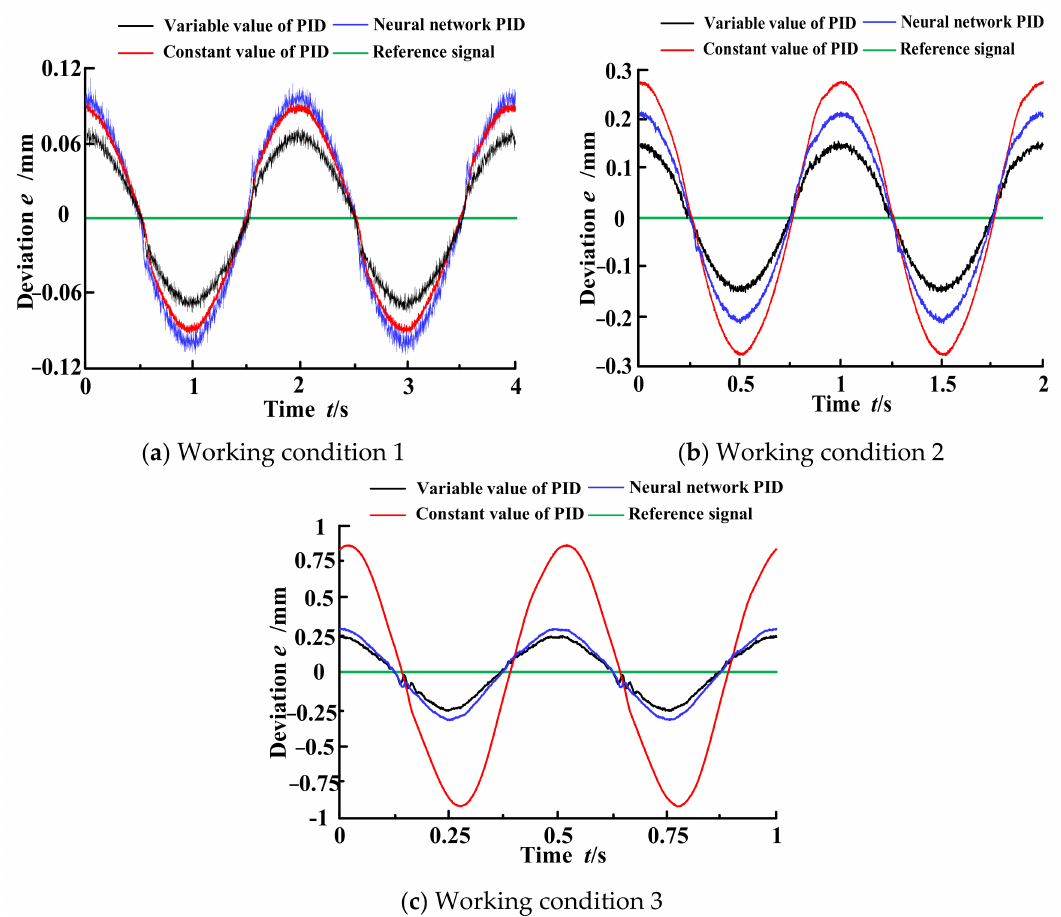
Figure 19. Comparative deviation curves of the different PID control methods.